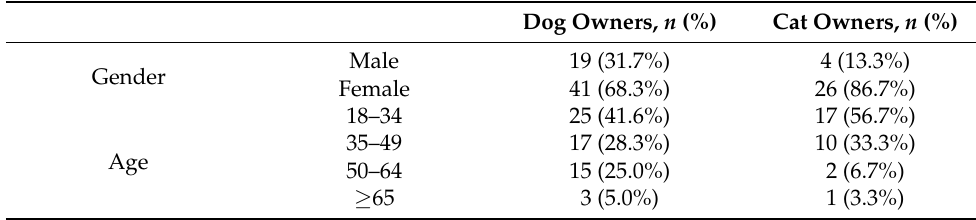
Table 3. Demographics of owners ( n =